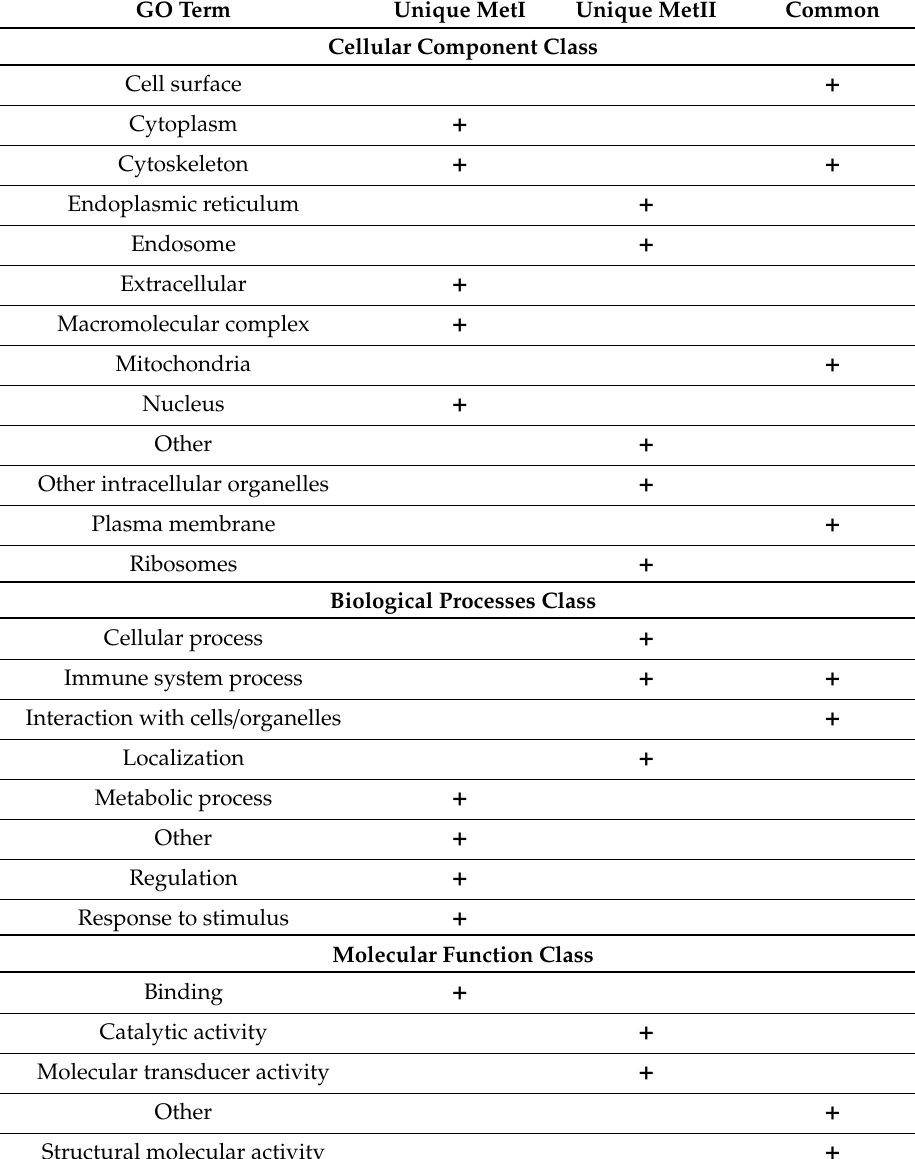
Table 2. Highest percentage of annotated proteins within each GO